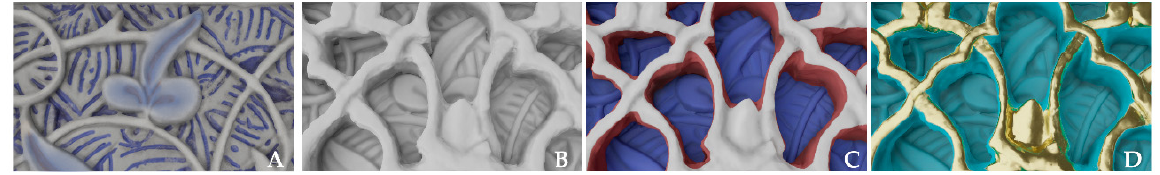
Figueiredo (2017) [75]: ( A ) mid-14th century; ( B ) early 19th century; ( C ) mid-19th century; ( D ) late 19th century.